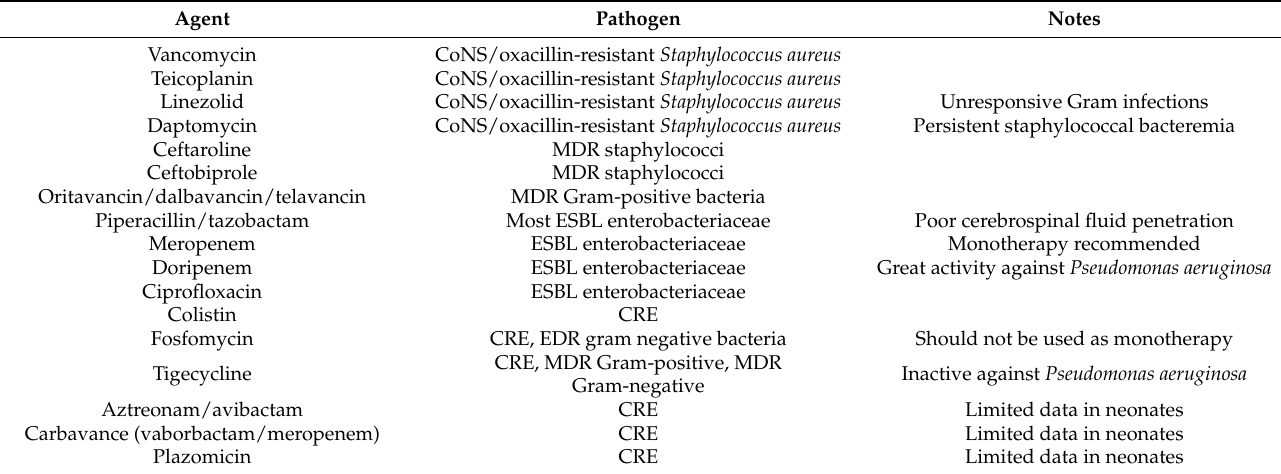
Table 2. Novel therapies for resistant pathogens in neonatal